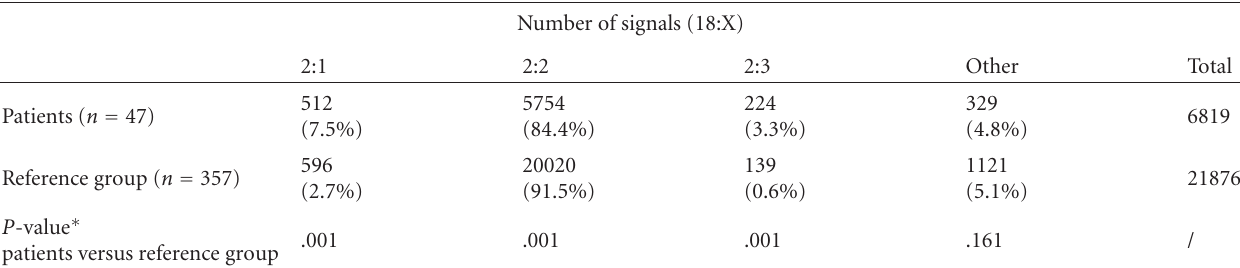
patients versus reference group